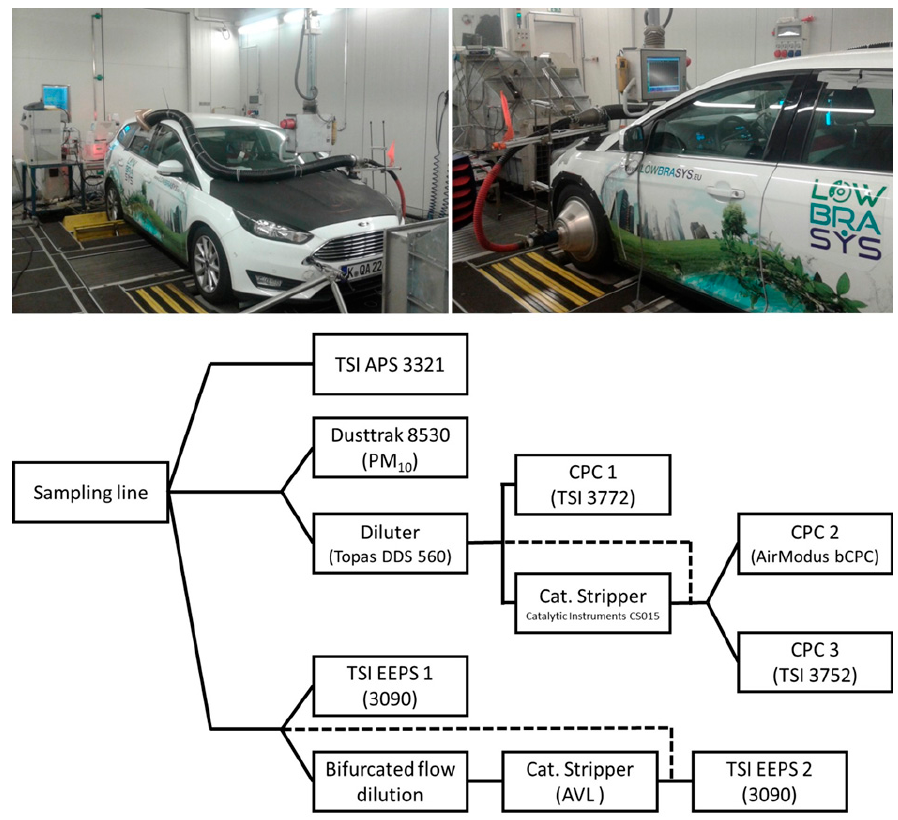
Figure 1. Top-view of the instrumented vehicle on the chassis dynamometer. Brake particles are generated at the front left enclosed wheel (right). Bottom–A schematic overview of all measurement devices. Dashed lines indicate variations of the setup that were used within the measurement campaign.